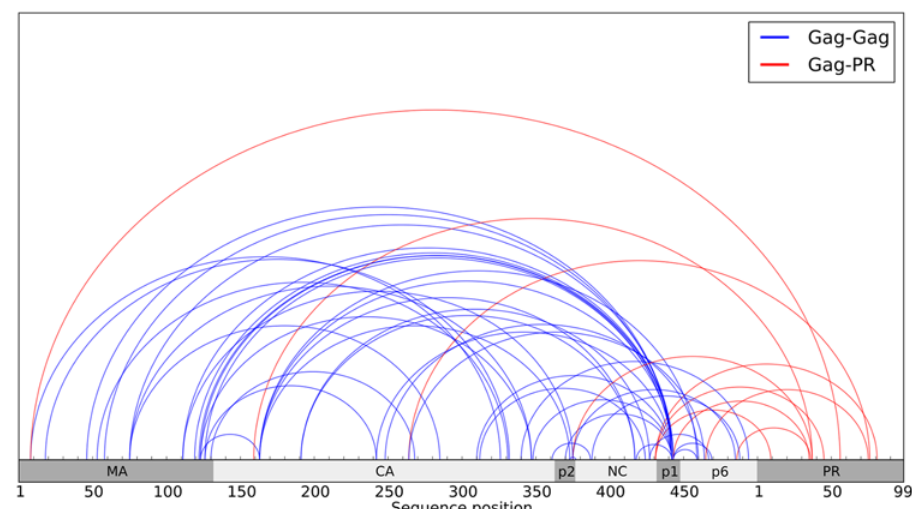
Fig 6. Strongest inter-protein correlations among PR and Gag proteins. Each semicircle denotes a correlation between the positions located at its endpoints. The strongest 50 correlations as measured by mutual information (MI) from the following regions are shown: Gag-Gag (blue), Gag-PR (red).